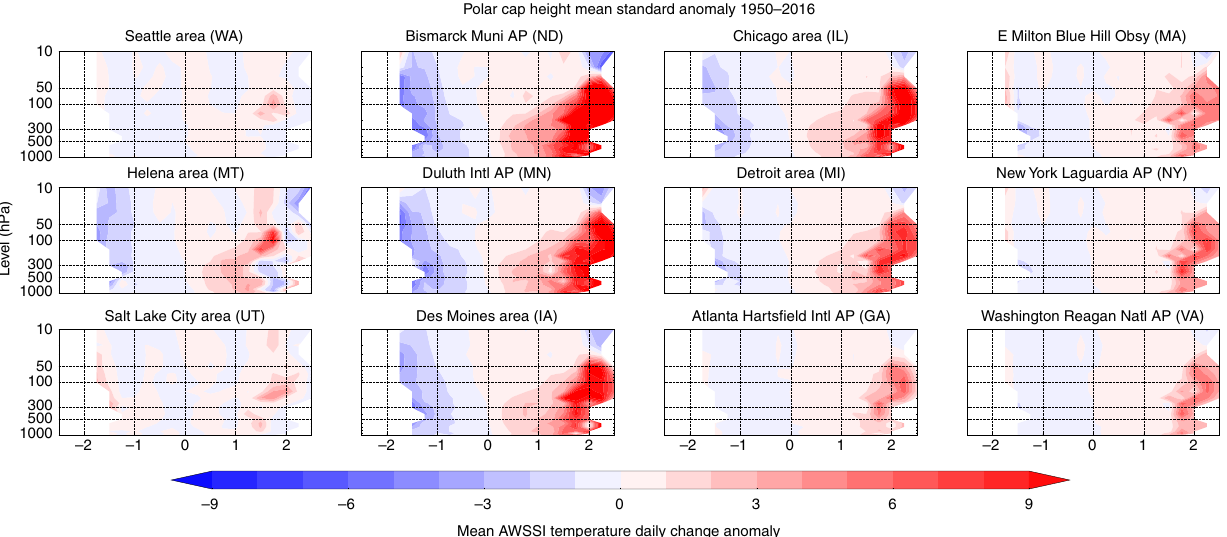
Fig. 3 Warm Arctic related to colder winter temperatures. Temperature contribution to the average daily change in the AWSSI (Accumulated Winter Season Severity Index) at selected weather stations across the US associated with polar cap geopotential height anomalies (PCH) from the surface to the mid-stratosphere (10 hPa) 1950 – 2016. Anomalies computed relative to climatology from 1981 to 2010